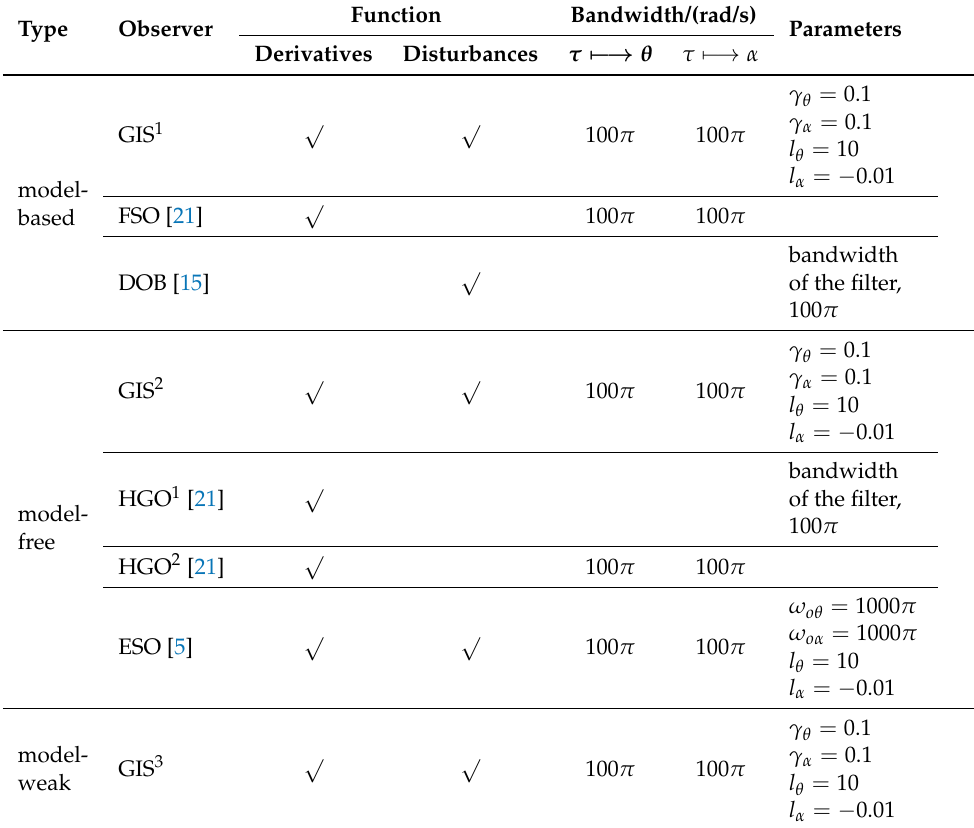
Table 2. Parameters of